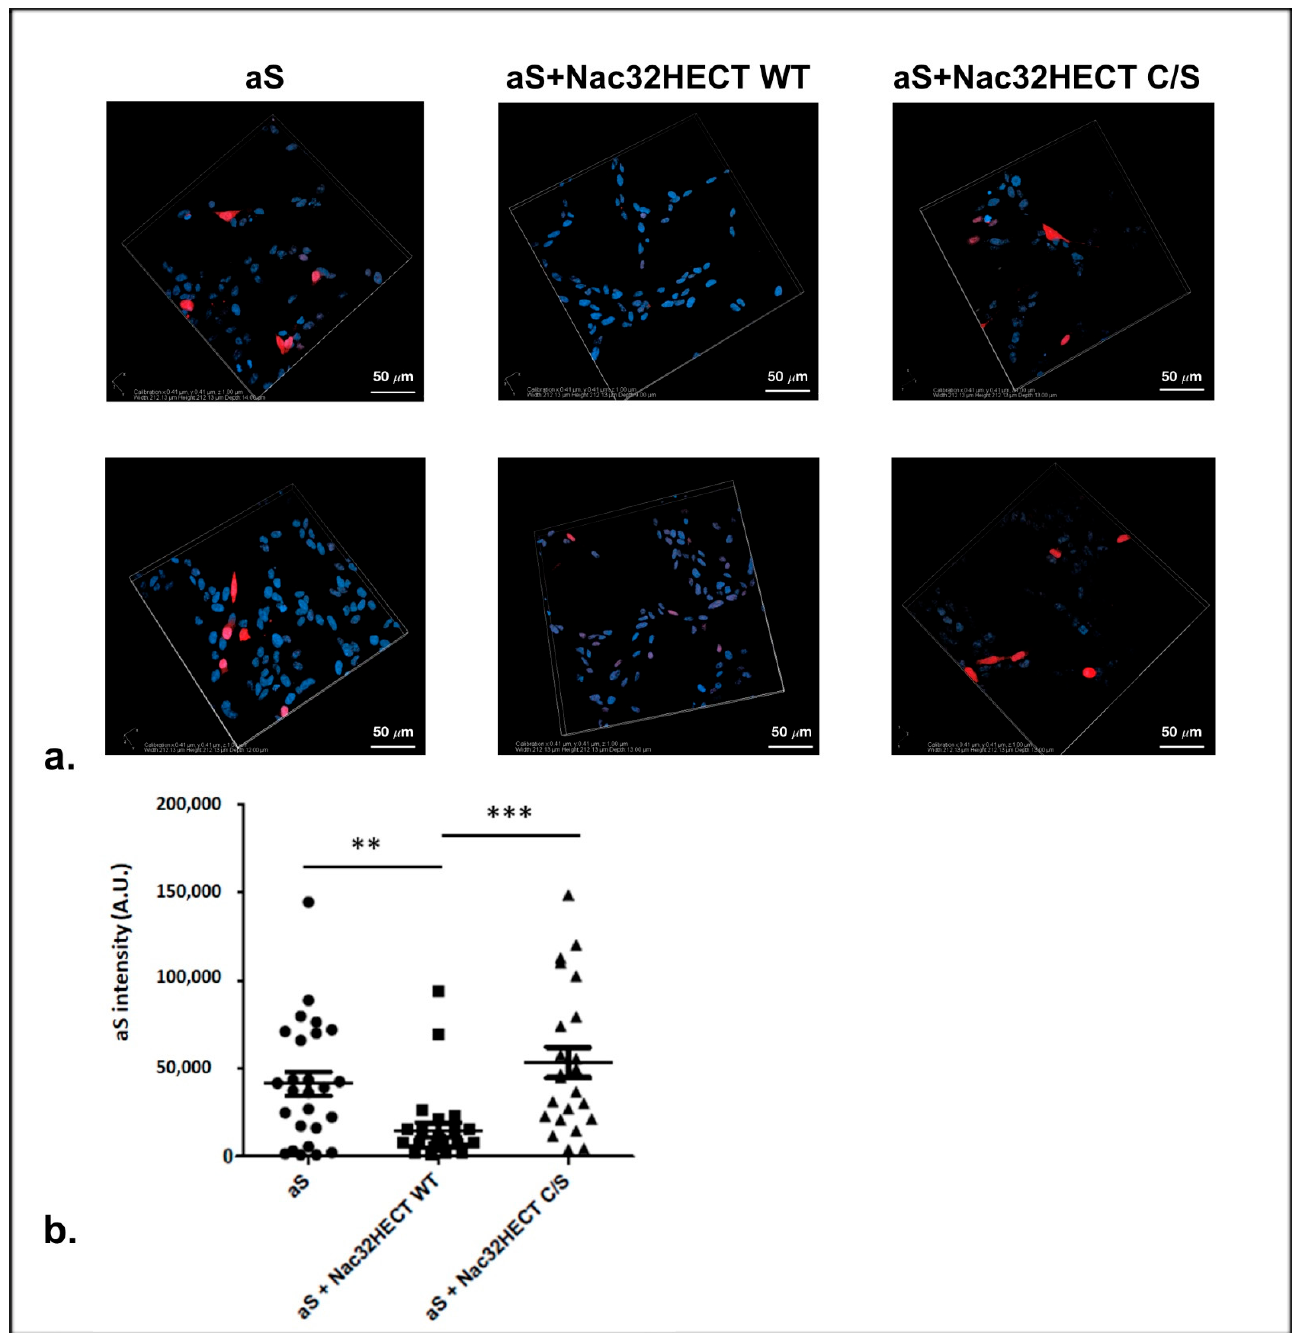
Figure 8. Nac32HECT overexpression affects aS intracellular amounts. Two µ g of a plasmid expressing aS (pHM6- alphasynuclein-WT) were transfected in the neuroblastoma SH-SY5Y cell line alone or in combination with 2 µ g of LVs encoding for either Nac32HECT WT or Nac32HECT C/S. Twenty-four hours later, cells were fixed with PFA (4% v / v ), permeabilized with Triton (0.5% v / v ) and incubated with an anti-aS (Abcam) antibody, followed by an anti-rabbit rhodamine secondary antibody. Nuclei were marked with DRAQ5™ (ThermoFisher Scientific). The glasses were mounted in glycerol- PBS media and analyzed by confocal microscopy, by maintaining the same laser setting for all the acquisitions. Confocal imagines are reported in ( panel a ), while ( panel b ) shows the statistical analysis performed by adopting five z-stack images per each sample from a single experiment ( t test, *** p < 0.0001 and ** p < 0.001). Scale bar in panels “a” corresponds to 50 µ